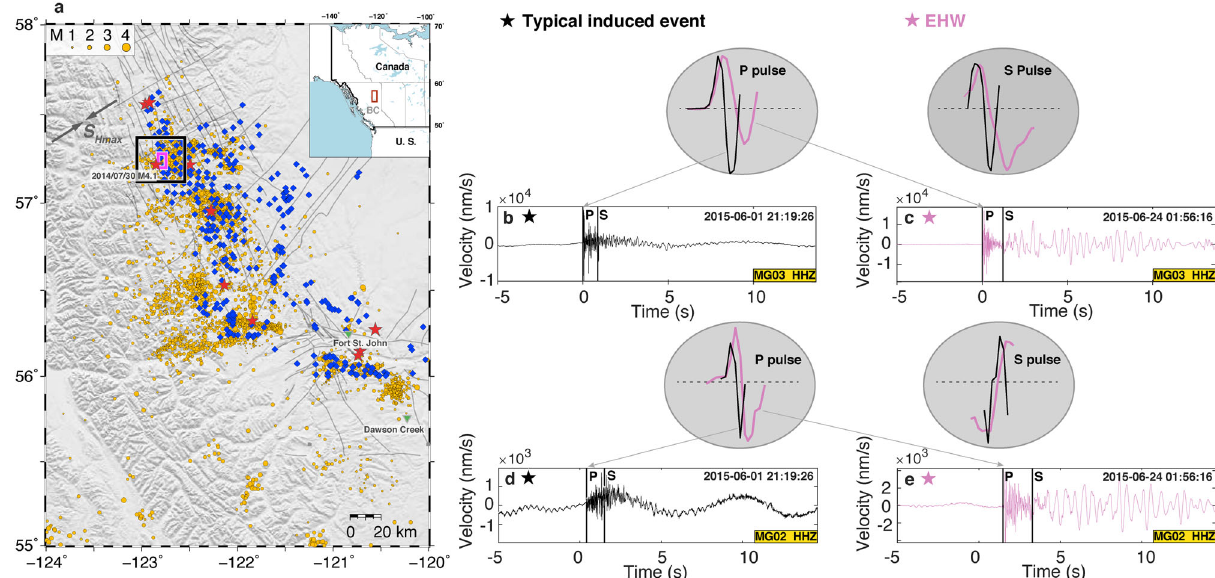
Fig. 1 Study area and EHWs. a Hydraulic fracturing activity and seismicity in northeast British Columbia, Canada. The top-right inset shows the geographic location of our study area (red rectangle). Blue diamonds: hydraulic fracturing injection wells between 1 Jan 2014 and Dec 31, 2016, reported by the British Columbia Oil and Gas Commission. Yellow dots: earthquakes during the same period 5 . Stars: 10 M 4 – 5 earthquakes since 2008 5,6 . Black rectangle: study area in which EHWs occurred. Pink rectangle: the area plotted in Fig. 2a. b , c Comparison between representative examples of a typical induced event (black trace) and an EHW (purple trace), marked in Fig. 2a. Both waveforms are from the vertical component of station MG03 with comparable source- station distance (1.32 km vs. 1.65 km) and magnitudes (~ M W 1.5). Manually picked P/S-arrivals are marked. The comparison of P/S-pulse shape demonstrates the relatively wider pulses for EHWs (see text). d , e The same as b and c but for waveforms recorded at station MG02. Both events show longer coda durations with slightly larger epicentral distances. Note that although both types of events have extended coda durations, the EHW contains a relatively larger proportion of lower-frequency energy in the